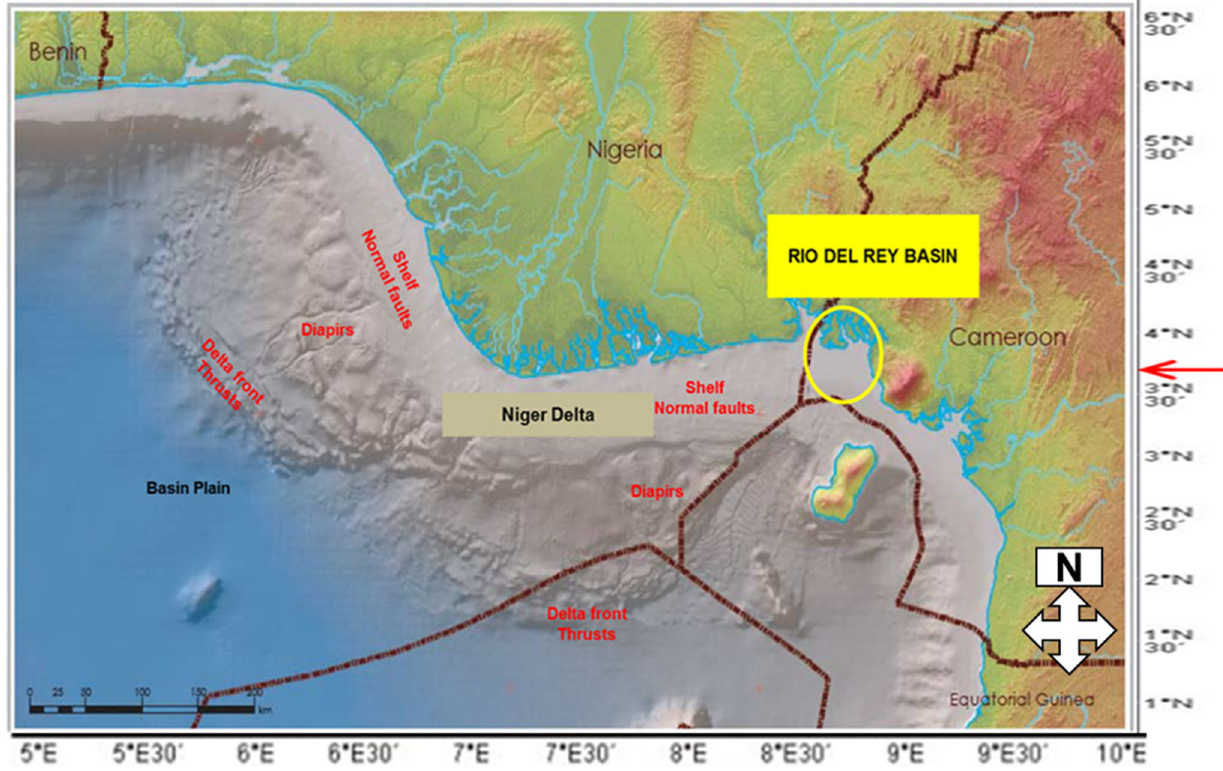
Fig. 1 Location map of the entire Rio Del Rey (RDR)